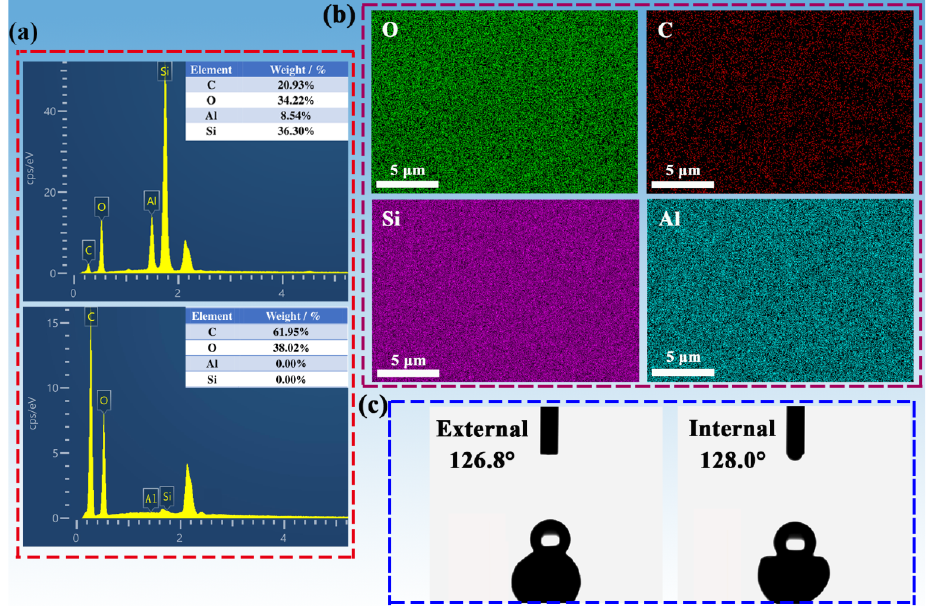
Figure 5. ( a ) EDS spectra of SCAB ‐ 4 and AAB with weight concentration for C, O, Si and Al. ( b ) EDS elemental (C, O, Si and Al) mapping images of SCAB ‐ 4. ( c ) External and internal water contact angles of SCAB ‐ 4.